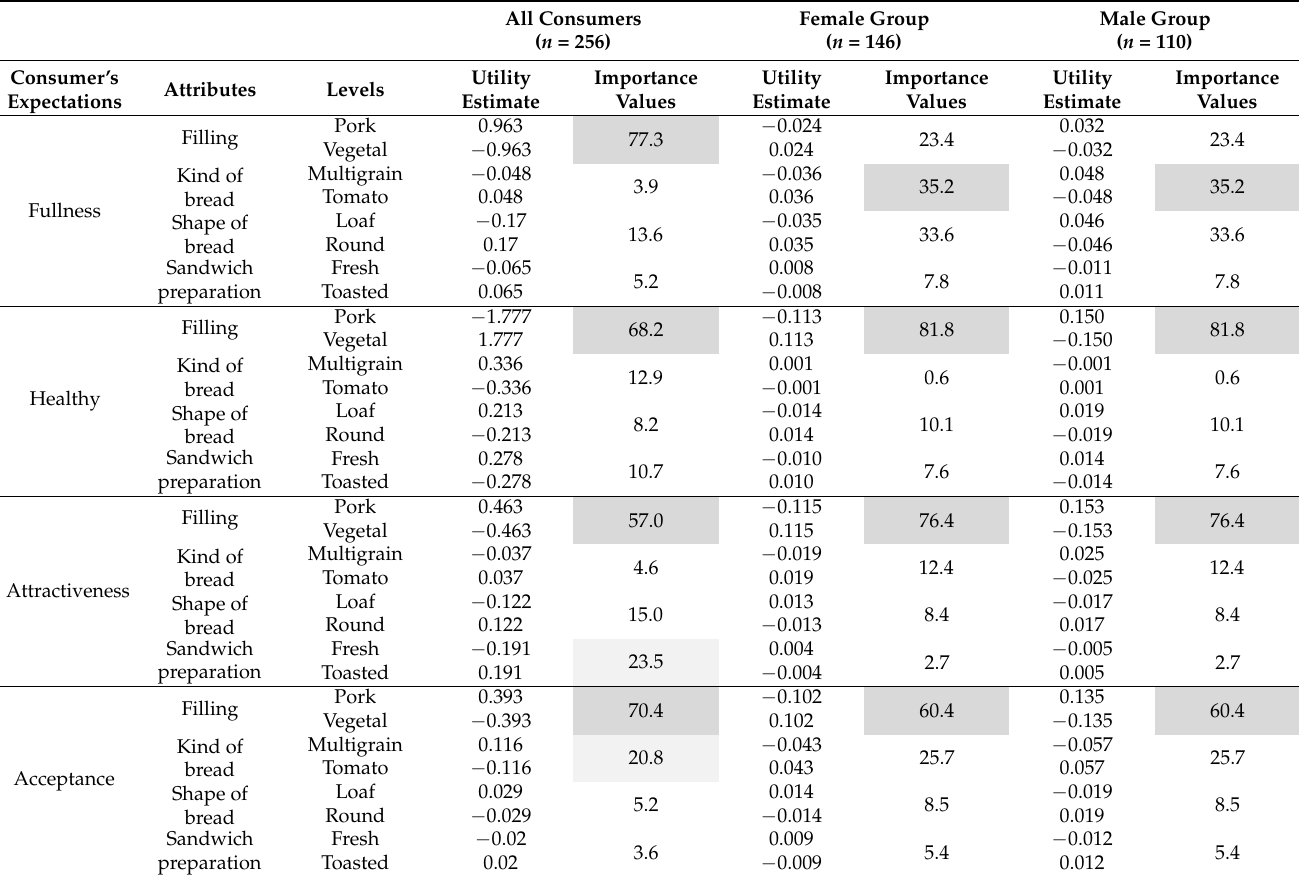
Table 6. Conjoint analysis results for each consumers’ expectations between attributes-level